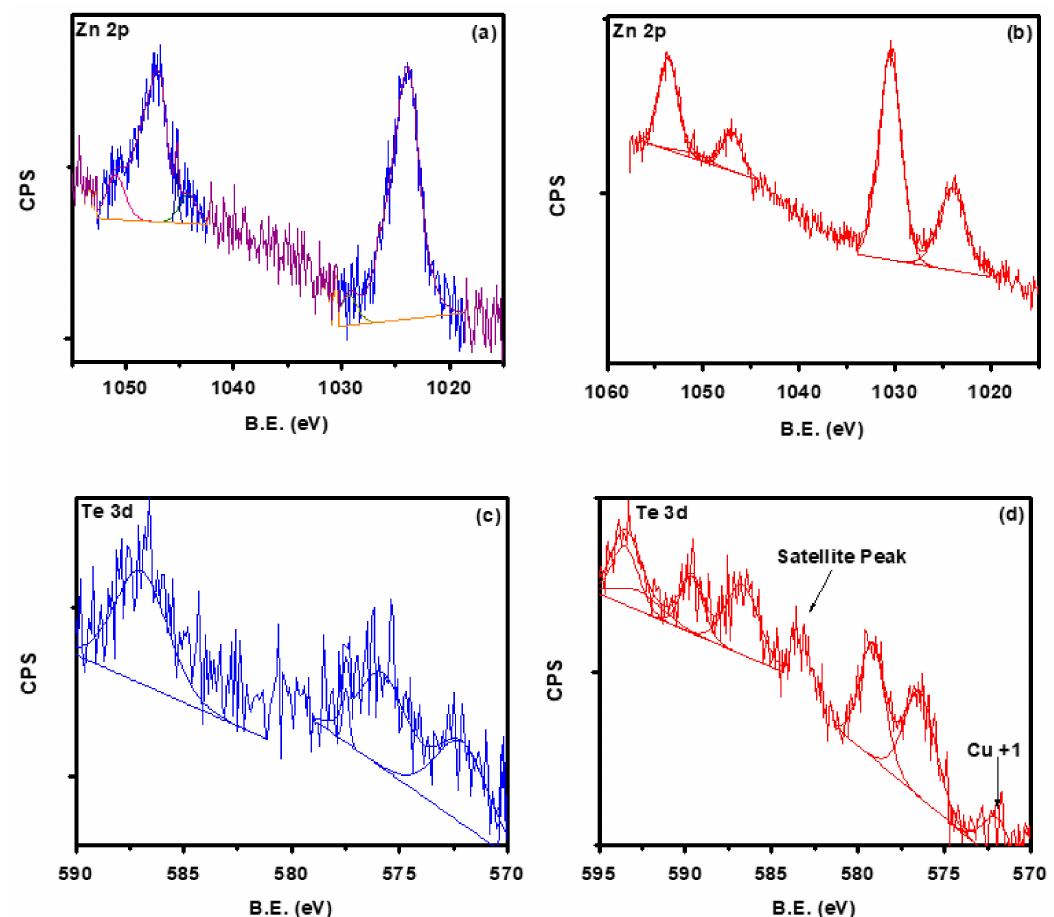
Figure 7. De-convoluted XPS analysis of Zinc-2p for ( a ) un-doped and ( b ) Cu-doped ZnTe thin film samples. De-convoluted XPS analysis of Tellurium-3d for ( c ) un-doped and ( d ) Cu-doped ZnTe thin film